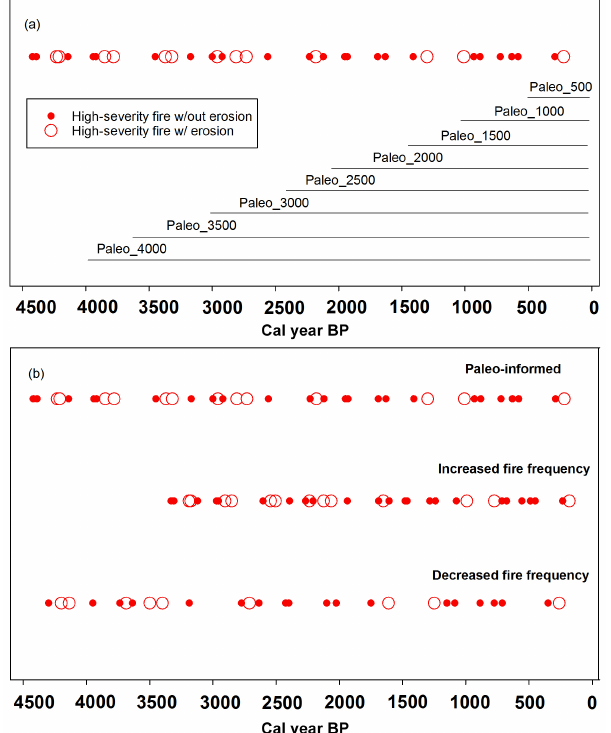
Figure 1. Paleo-informed fire history scenarios used to drive the DayCent model. (a) Fire history record form Chickaree Lake (red circles), with horizontal lines illustrating the duration of the record used in the incremental partially paleo-informed scenarios (Pa- leo_500...4000). (b) The same full Chickaree Lake fire history record used in the paleo-informed scenario (a) , with the two ad- ditional scenarios representing a 25% increase and 25% decrease in fire frequency.